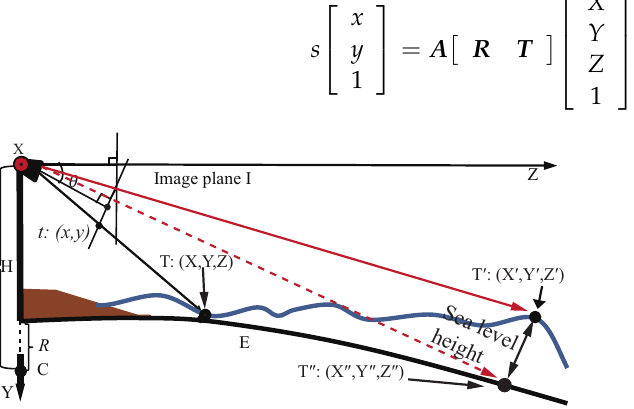
Figure 6. Set up user coordinate system (UCS).